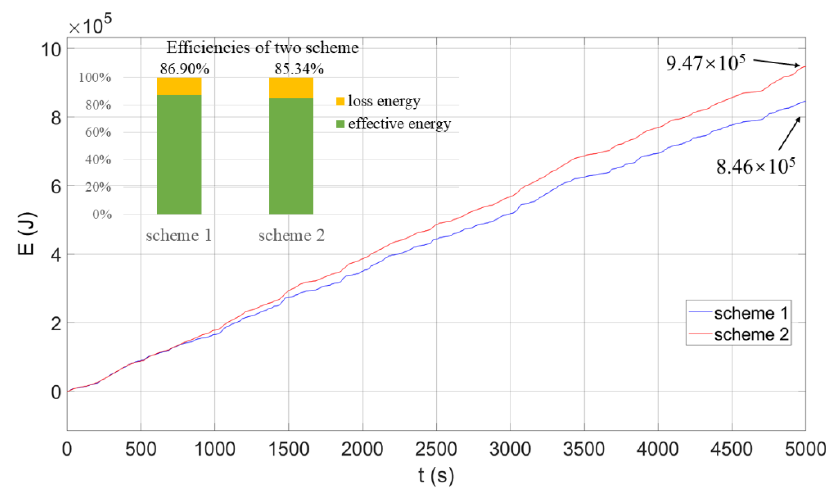
Figure 18. Optimal Pareto front.